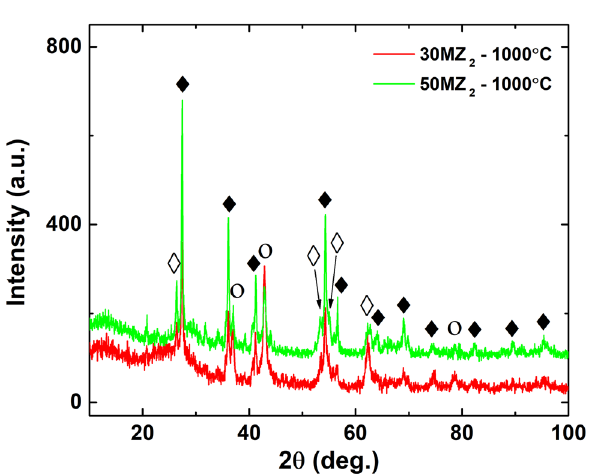
Figure 4. XRD patterns of ( a ) initial PAN, MZ 2 , 30MZ 2 and 50MZ 2 ; ( b ) hybrid nanocomposites thermally treated at 550 °C.